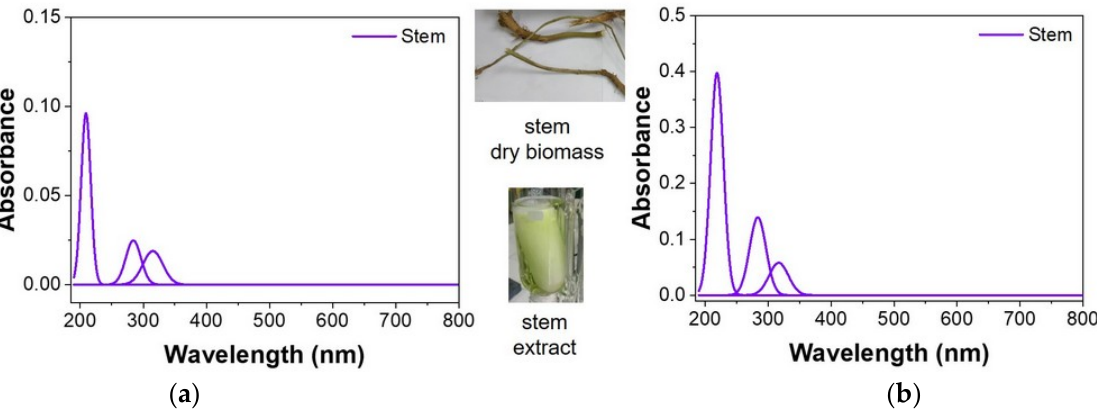
Figure 9. UV–VIS profile absorption spectra after deconvolution for Datura innoxia stem matrix in ethanol extract ( a ) and 1-butanol extract ( b ).